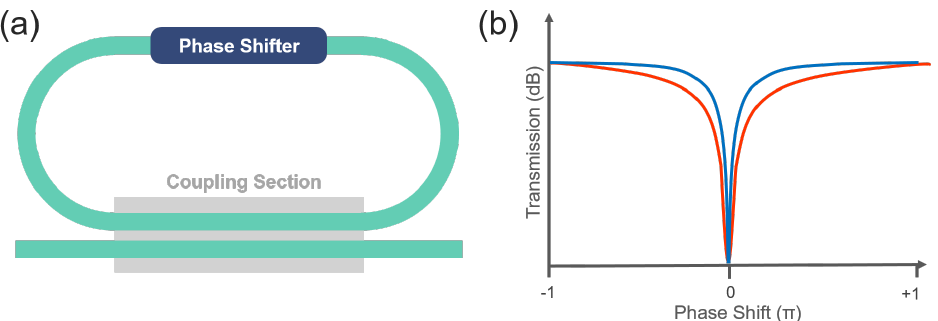
Figure 2. ( a ) Schematic of Si racetrack resonator with III–V/Si hybrid MOS optical phase shifter. ( b ) Numerically calculated transmission of a MZI modulator and a racetrack